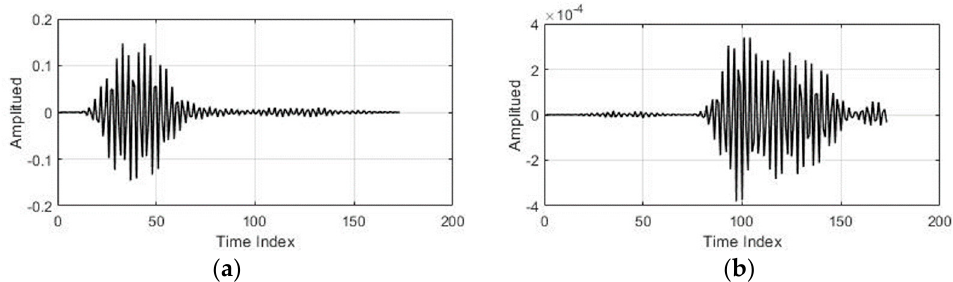
Figure 4. Gesture signal for single PRI: ( a ) before and ( b ) after clutter removal.